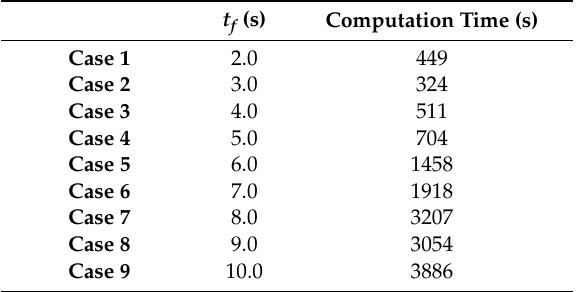
Table 5. Computation times for the optimization